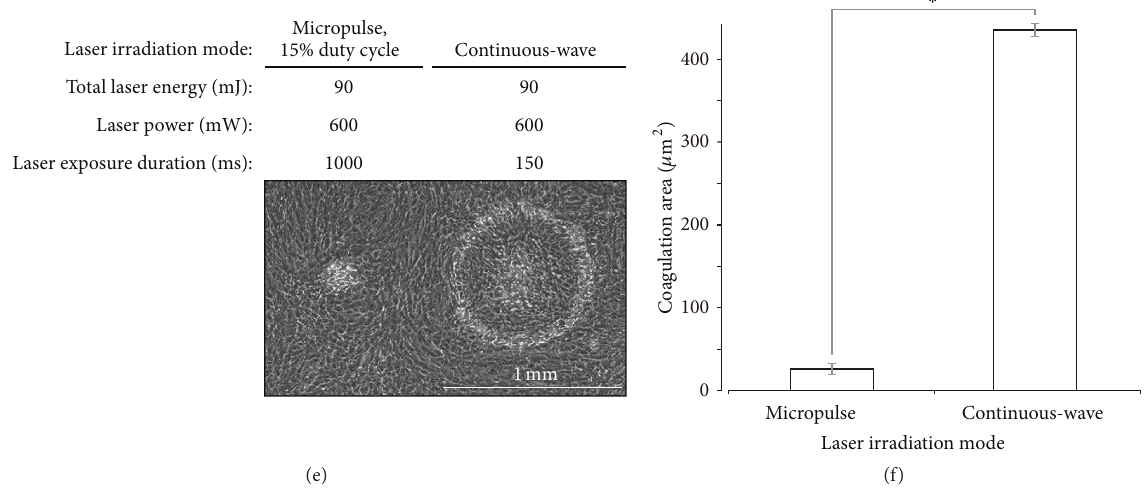
Figure 2: Establishment of laser parameters for sublethal photothermal stimulation on a cultured cell layer using micropulse-mode laser irradiation. (a) A micropulse-mode laser emits short, intermittent pulses of laser energy. At a 15% duty cycle, the laser was on for 0.3 ms during each 2.0 ms period. When the total laser exposure duration was 1000 ms, the laser cycle was repeated 500 times. (b) Representative phase-contrast microscopy images taken 2 h after laser irradiation with a micropulse laser. The laser had a 15% duty cycle and was set to various laser powers (600–800 mW) and laser exposure durations (500–1000 ms). Multiple spots were made on a single one-cell layer culture plate 1mm apart in both the 𝑋 and 𝑌 directions. The duration was varied along the 𝑋 -axis, and power was varied along the 𝑌 -axis. The laser spot size remained constant at 200 𝜇 m. (c) Areas of morphological change are shown in (b), as measured with NIH Image J software. Data represent the mean ± standard error of 10 independent experiments. Both laser exposure duration and laser power were significantly correlated with coagulation area (Spearman’s correlation coefficient: 𝑟 > 0.8 , 𝑝 < 0.05 ). (d) Representative bright-field (left panels) and fluorescent (center and right panels) images around laser irradiation sites, as captured with confocal microscopy, at the indicated times following laser irradiation. Sublethal photothermal stimulation was performed with the following laser settings: 15% duty cycle, 1000 ms laser exposure duration, and 600mW laser power. Note that no dead cell signals (red fluorescence) were observed within the 24 h following laser irradiation. (e) Representative phase-contrast microscopy images 2h after laser irradiation of single-cell layers with a laser in the micropulse (left) and continuous-wave (right) modes. The total laser irradiation energy was 90 mJ in both cases. (f) Mean coagulation area of spots made with a laser in the micropulse and continuous-wave modes shown in (e). Error bars represent one standard error ( 𝑛 = 12 ). The asterisk ( ∗ ) indicates a statistically significant difference between means (Mann-Whitney 𝑈 tests, 𝑝 < 0.01